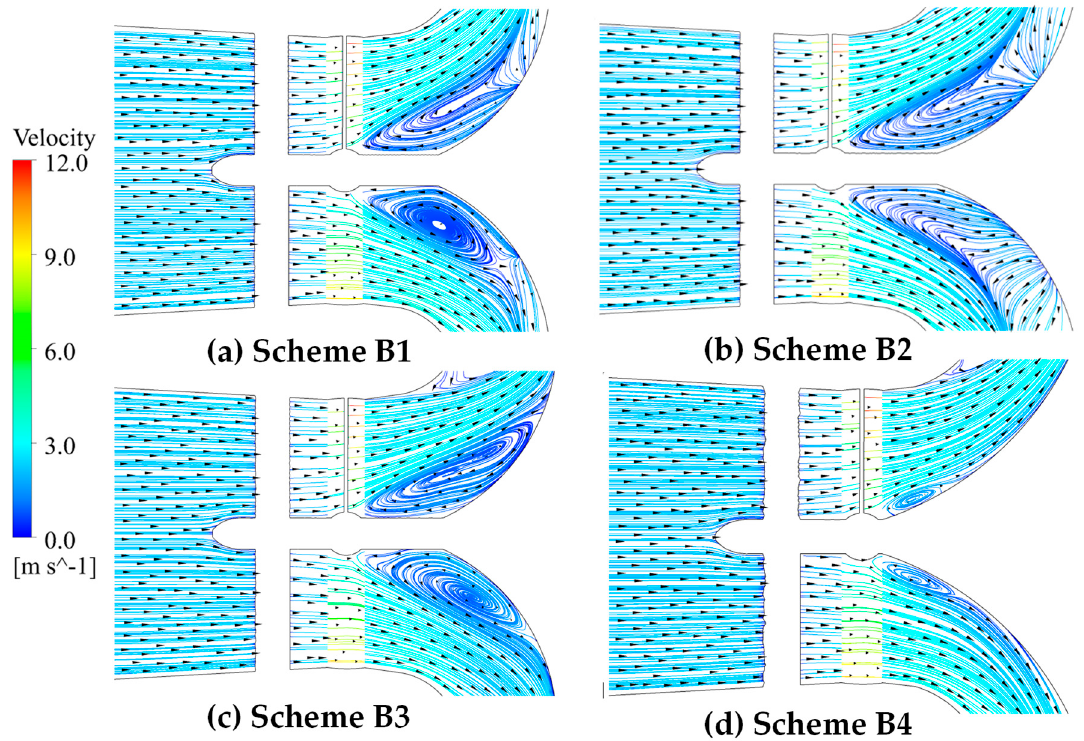
Figure 9. Velocity distribution of vertical section within different turbine at v = 2.0 m/s. ( a ) Scheme B1; ( b ) Scheme B2; ( c ) Scheme B3 and ( d ) Scheme B4.